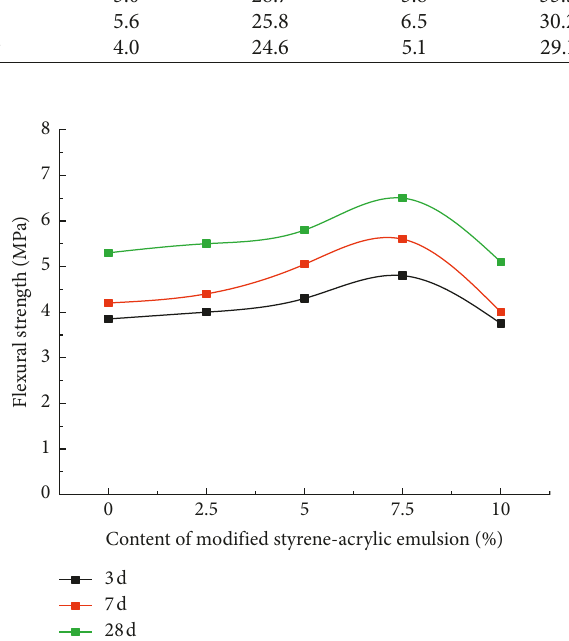
Figure 14: Influence of the modified styrene-acrylic emulsion on the flexural strength of the solidified cement slurry.